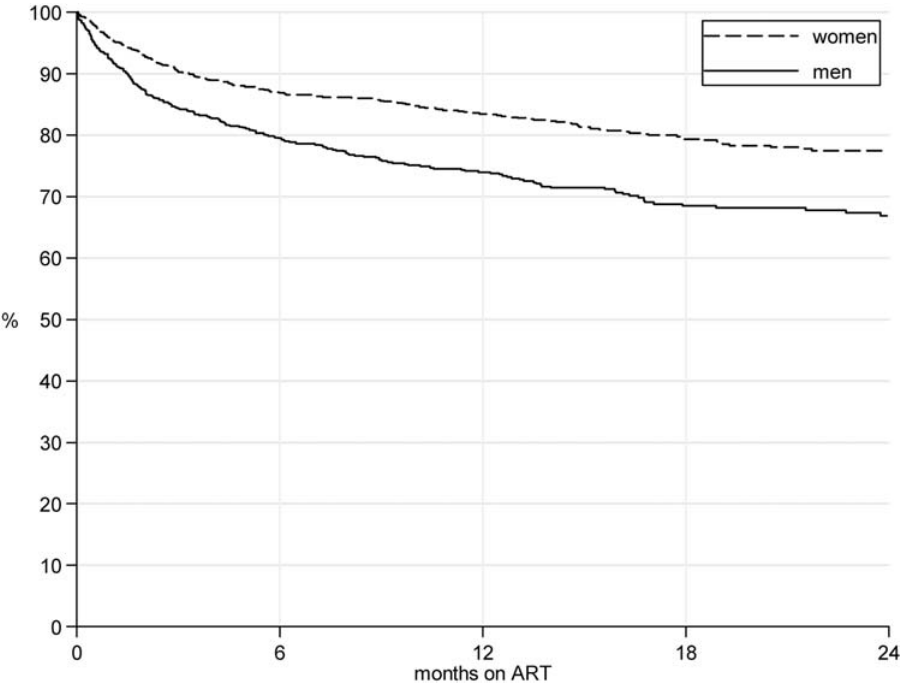
Figure 2. Kaplan-Meier estimates for retention of teachers in ART-program. n=3,636; 2,575 person-years of observation.